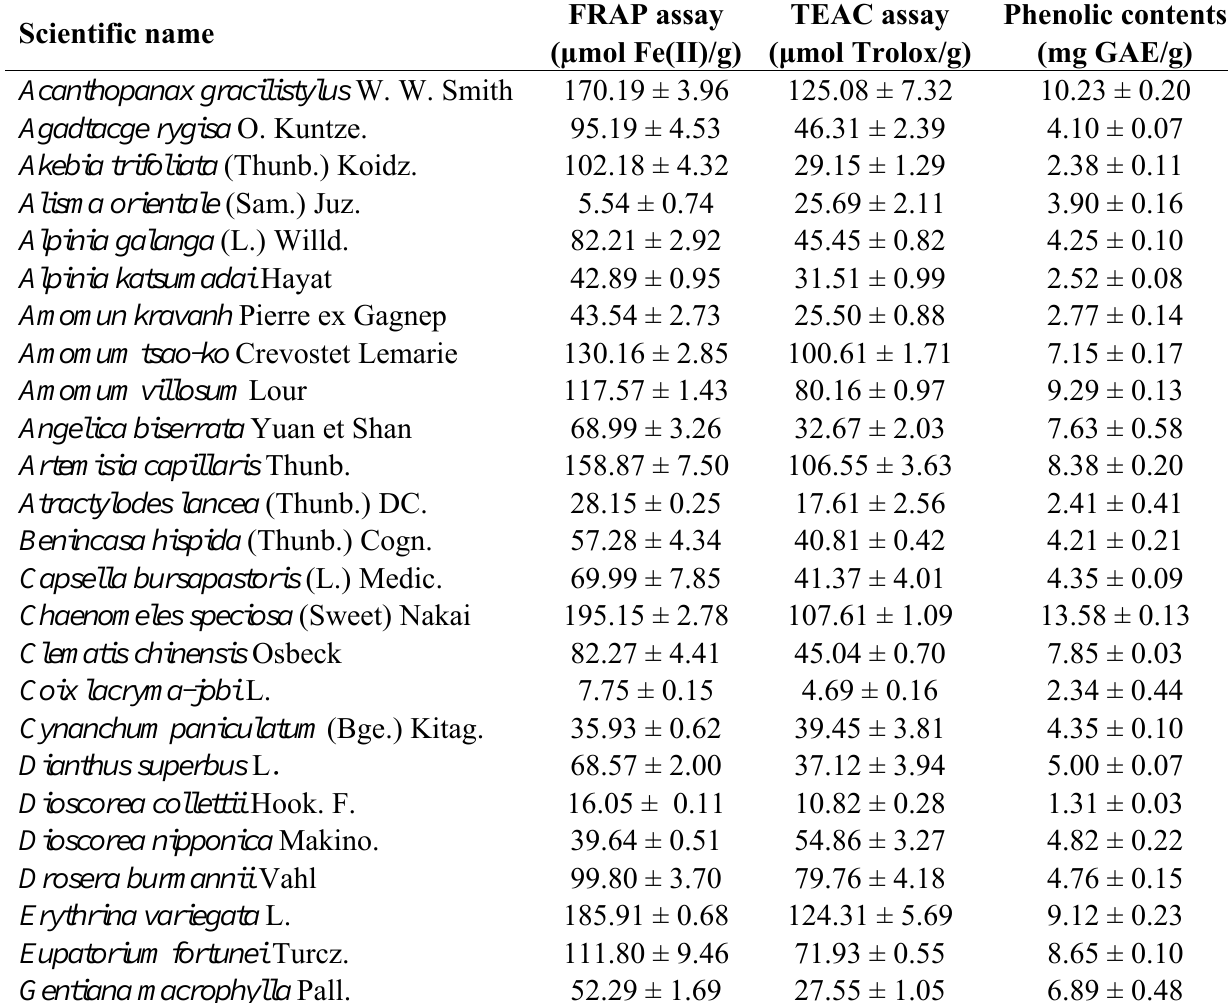
Table 1. Antioxidant capacities and total phenolic contents of 50 medicinal